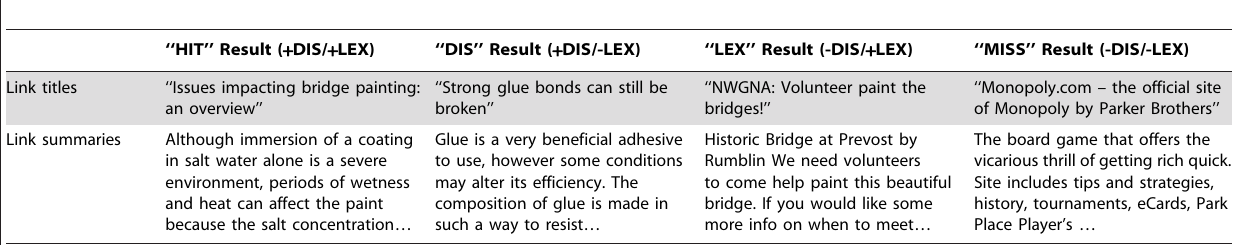
Table 2. Example of each type of result for the search topic ‘‘why do bridges need to be coated with special paint’’.